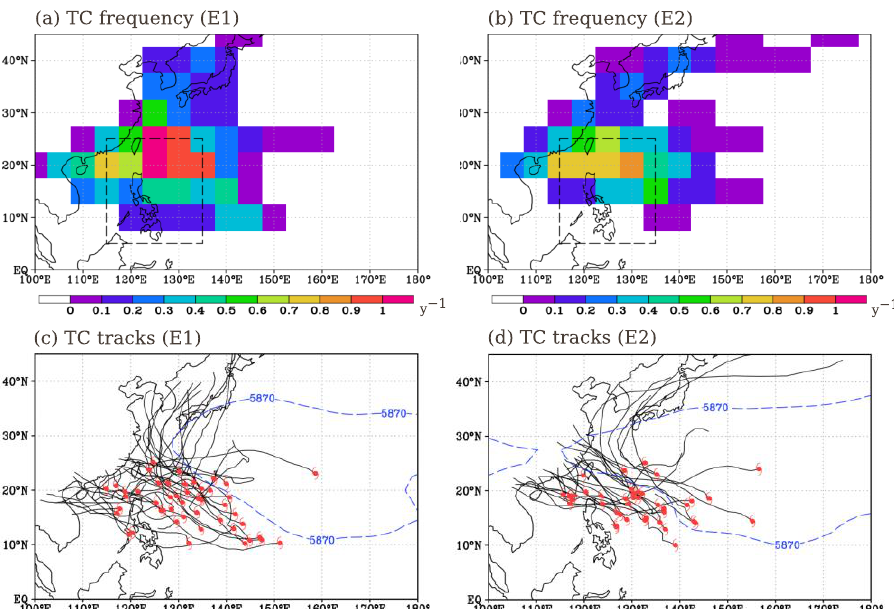
Figure 8. Tropical cyclone track frequency (per year) in P45 – P50 interpolated onto a 5 × 5° grid for: ( a ) E1 (1979 – 1993); and ( b ) E2 (1994 – 2008) based on JTWC track dataset. As in ( a ) but for TC tracks and location of 5870-m contour line of the 500-hPa geopotential height (dashed blue line) from: ( c ) E1 and ( d ) E2. Dashed box in ( a , b ) indicates the Philippine Area of Responsibility (PAR; 115° to 135° E and 5° to 25° N). The genesis locations in ( c , d ) are indicated by the red markings. Table 2. The seven-station averaged P TOTAL , P TC , and P NOTC for P45 – P50 (9 August – 7 September) during